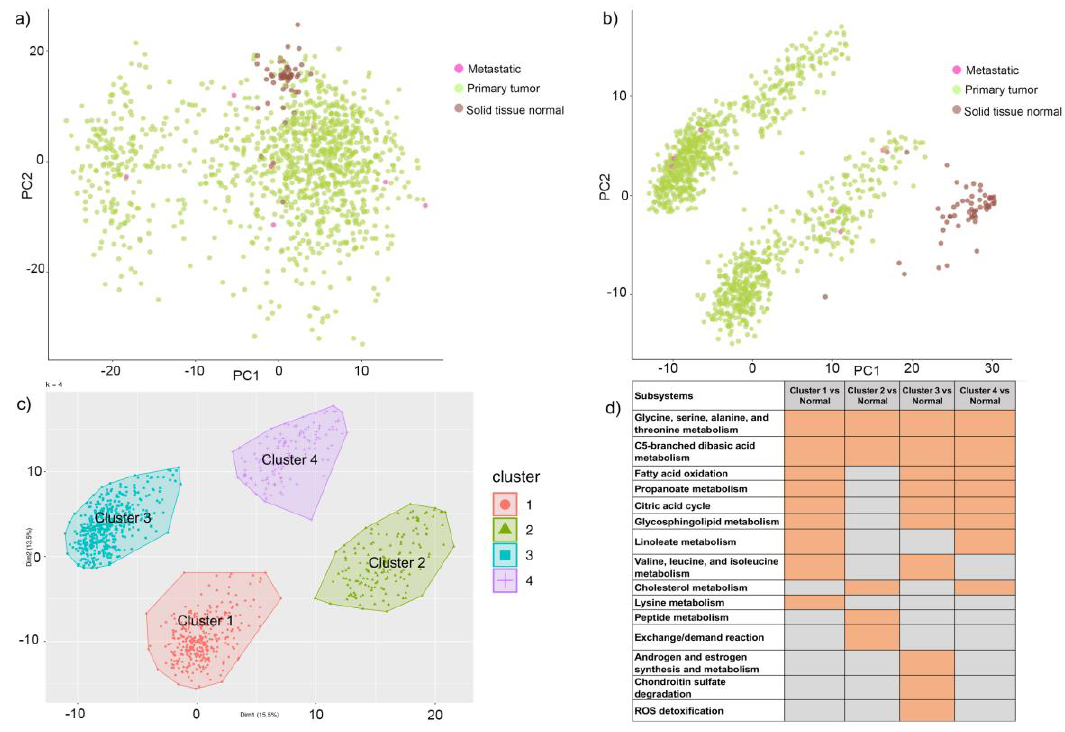
Figure 2. Cluster analysis of genes and reactions. ( a ) Principal component analysis (PCA) of metabolic genes (divergent values) of 1156 breast cancer samples from TCGA. Samples are colored as brown, green, and pink based on normal, primary or metastasis phenotype, respectively. ( b ) PCA of 1156 samples clustered based on metabolic reaction fluxes and colored with respect to sample type. Samples are colored as brown, green, and pink based on normal, primary, or metastasis phenotype, respectively. ( c )Four clusters of cancer samples indicating distinct metabolic profiles. The clusters have been labeled as 1, 2, 3, and 4. ( d )Heatmap representing enriched subsystems for each cluster when compared to normal samples. Orange fields indicate significant subsystems with a p -value < 0.05, and the gray fields indicate non-significant subsystems with a p -value >